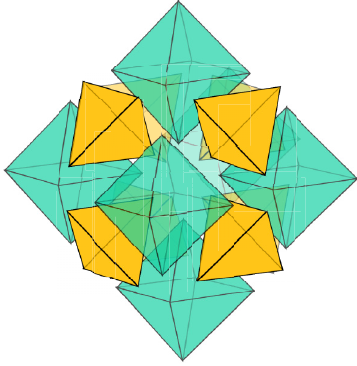
FIG. 7. Tetrahedral-octahedral honeycomb stratification used in the construction of a TDN for Chamon’s